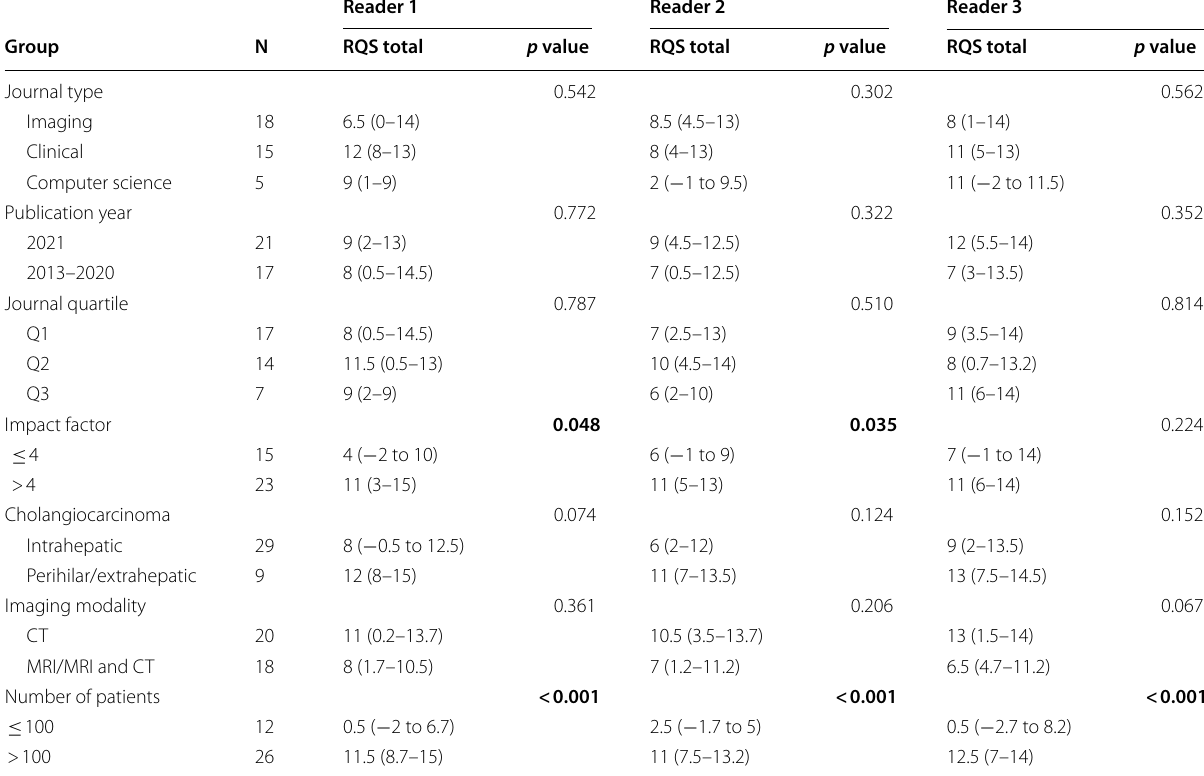
Continuous variables are expressed as medians and interquartile range (25th to 75th percentile) in parenthesis. Continuous variables were compared using the Kruskal–Wallis or the Mann–Whitney U test. Statistically significant values ( p < 0.05) are highlighted in bold CT, Computed Tomography; MRI, Magnetic Resonance Imaging